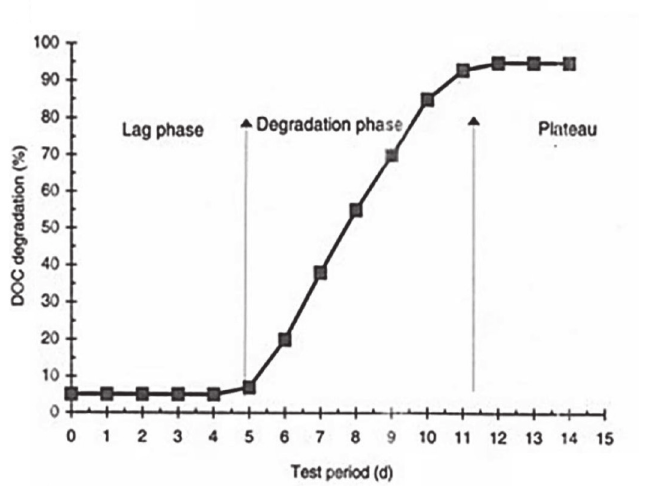
Fig. 7 – Degradation curve